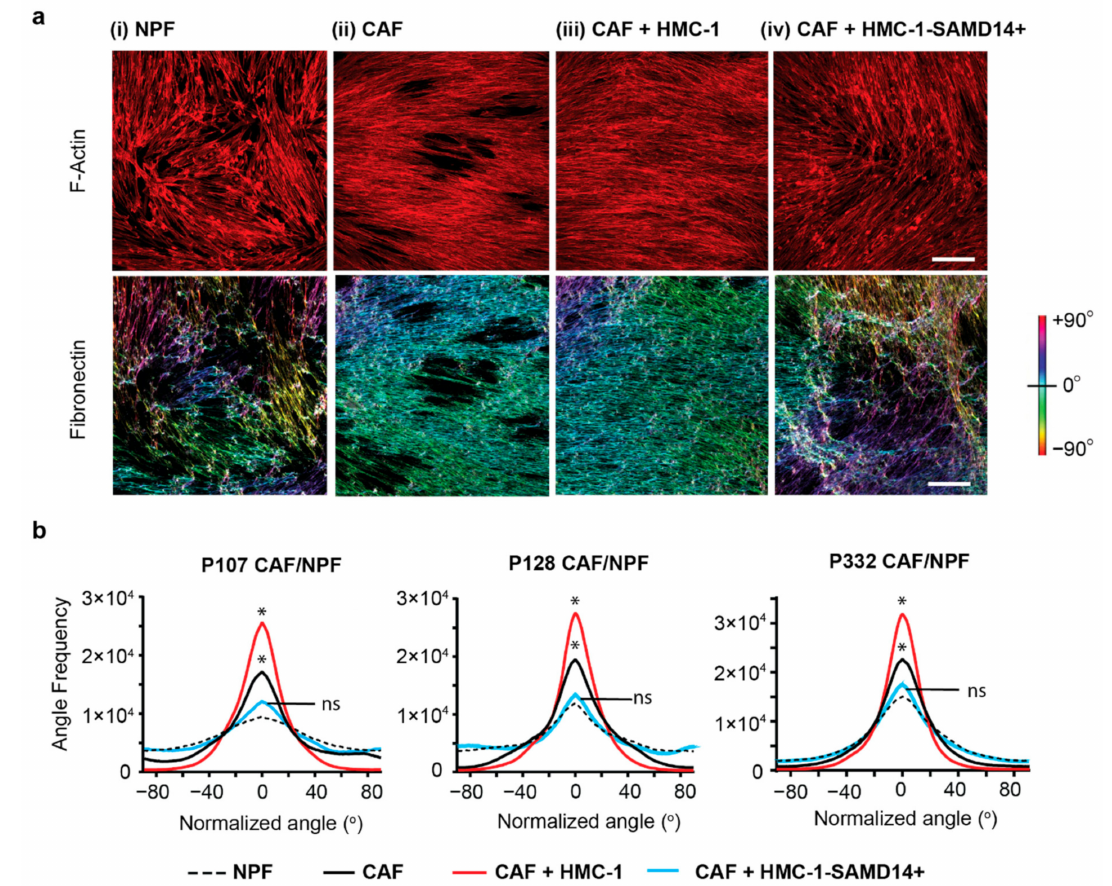
Figure 4. SAMD14 overexpression in mast cells abrogated ECM alignment in CAFs ( a ) Representative image of CAF and NPF derived from P128. Prostate fibroblasts were visualized with F-actin staining (red). Fibronectin staining show ECM fiber alignment for cell-derived matrices produced by (i) NPF, (ii) CAF and (iii) CAF + HMC-1 CM and (iv) CAF + HMC-1-SAMD14+ CM. ECM Images were processed and color-coded to represent the degree of fiber orientation distribution within each sample. Scale bar: 200 µ m. ( b ) Quantification of fiber alignment for NPF, CAF and CAF cultured with HMC-1 CM and HMC-1-SAMD14+ CM for the CAF and NPF derived from P332, P107, and P128. Line plots represent analysis with 4 technical replicates per patient, from 4 images per replicate. Statistics performed using Kruskal–Wallis test with Dunn’s post-hoc multiple comparisons test (*, p <0.05) to determine statistical significance. Data represented as